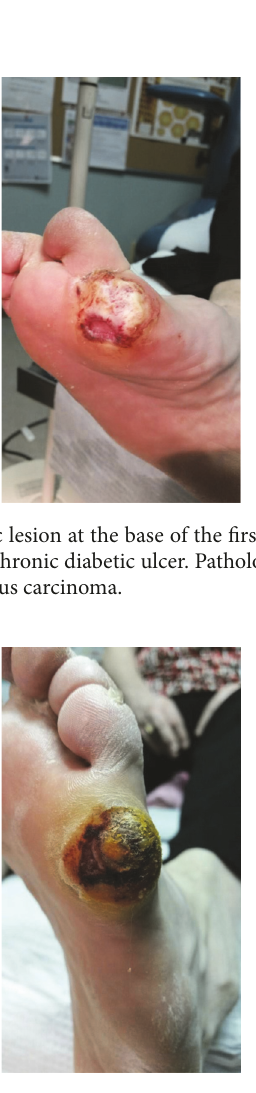
Figure 2: Painful exophytic lesion on the plantar surface of the left 5th MTP joint, which, after multiple biopsies, was confirmed by pathology to be verrucous carcinoma.